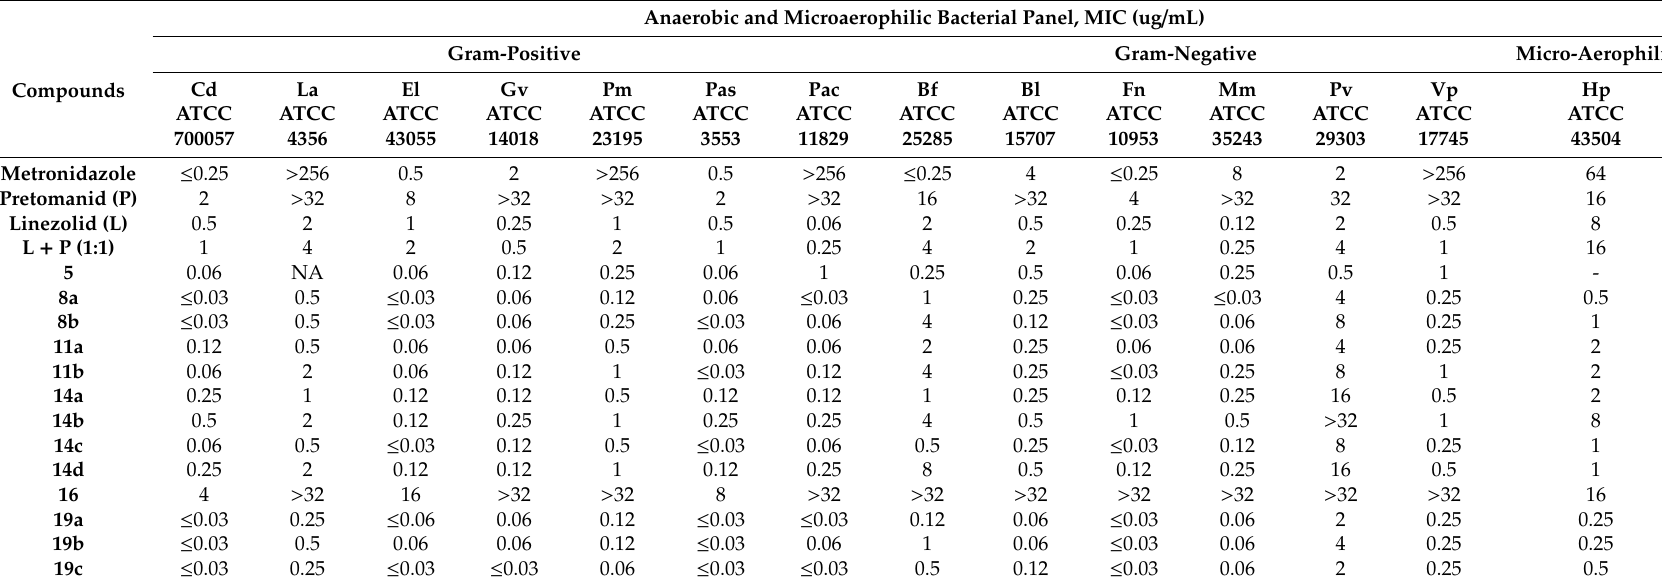
Table 3. Minimum inhibitory concentrations (MIC) of 12 conjugate molecules against clinically important anaerobic and microaerophilic bacterial strains.